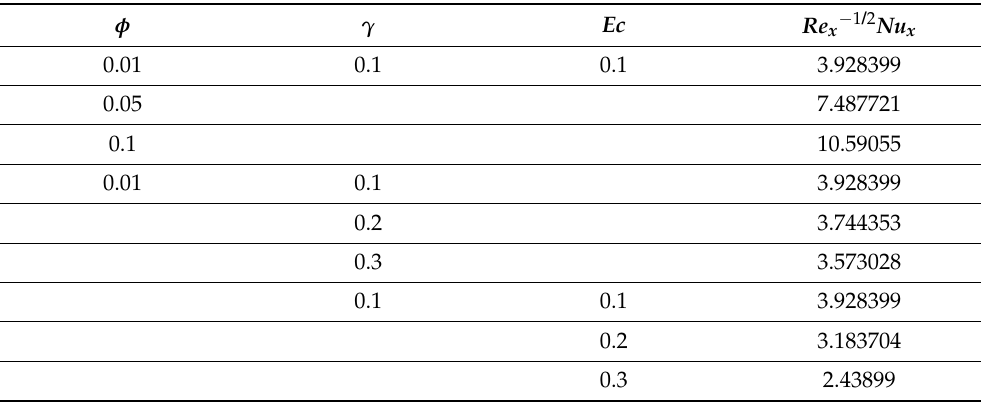
Table 3. Nusselt number variations for various